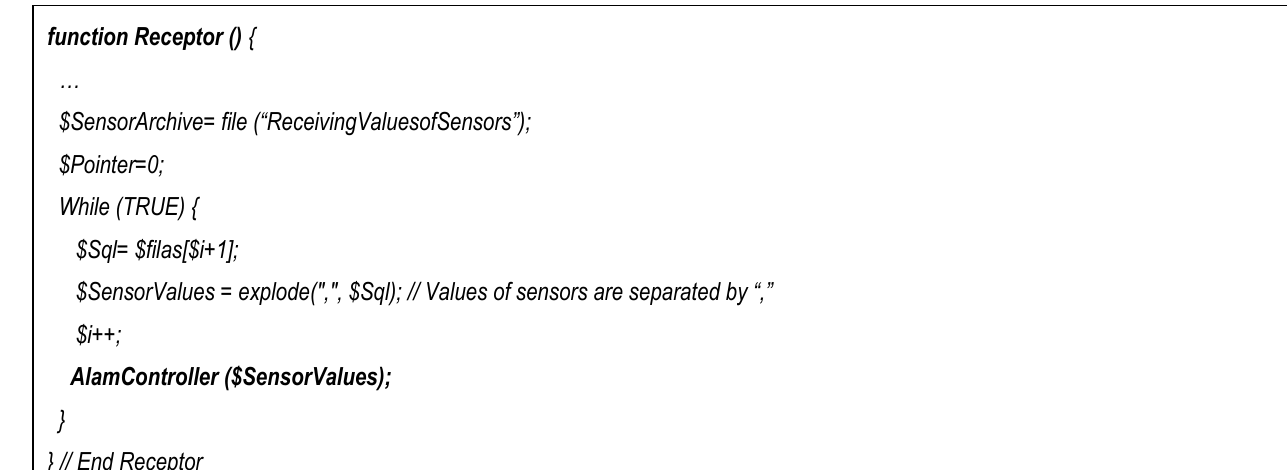
Figure 18. The PHP code of the Receptor.